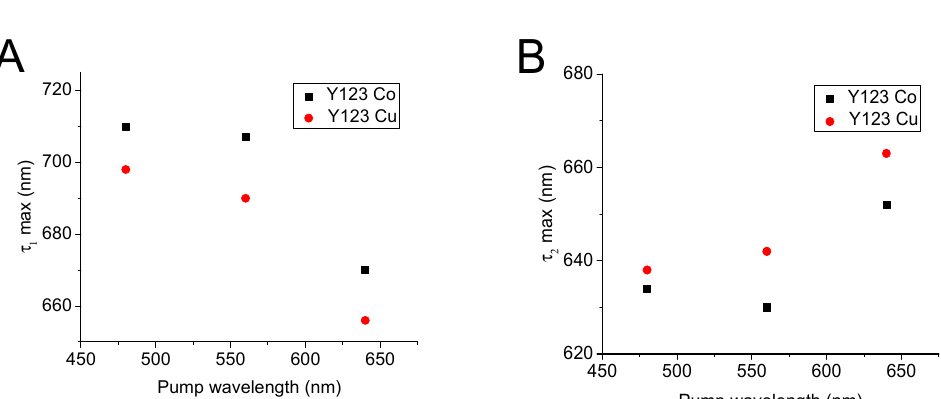
Figure 1. Pre-exponential factor spectra associated with the indicated time constants for a model with a three-exponential function with an offset for DSSC with Y123 dye and ( A ) cobalt- and ( B ) copper-based electrolyte for pump wavelength 560 nm.